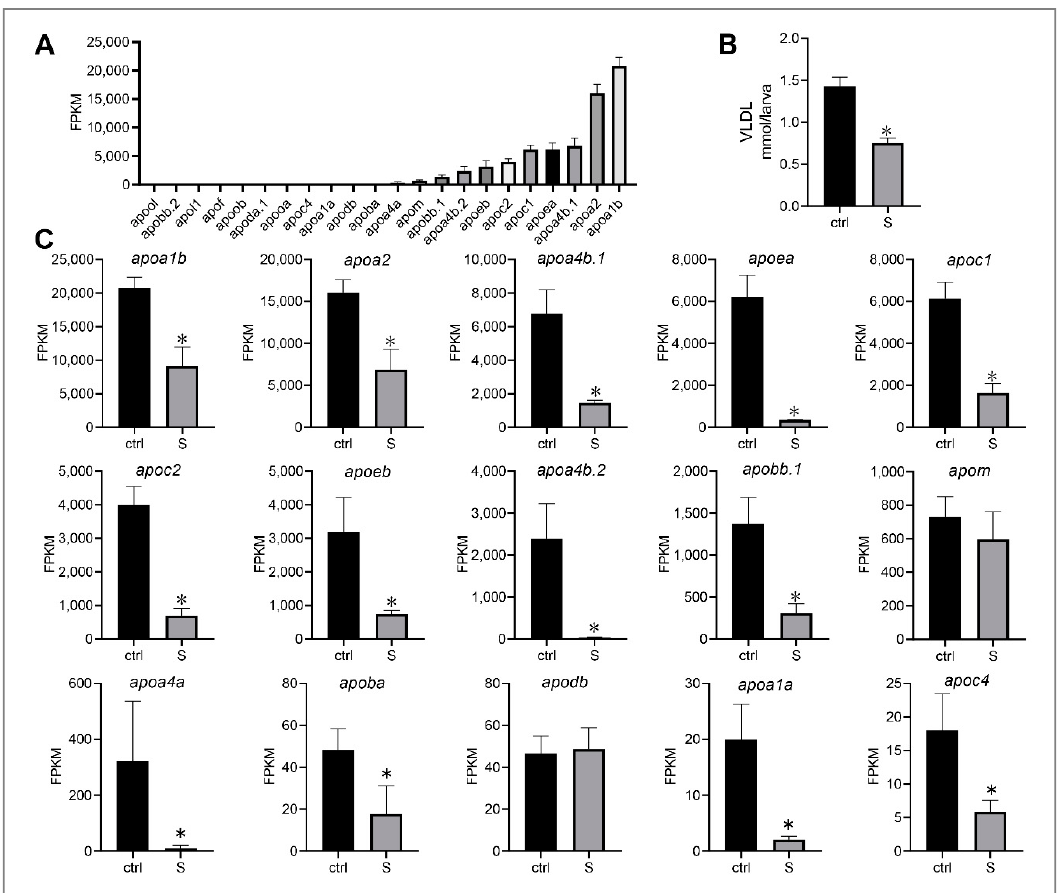
Figure 7. Effect of starvation on the gene expression involved in lipid transport in liver tissues. ( A ) Expression of apolipoprotein genes, including apoa1b , apoa2 , apoa4b.1 , apoea , apoc1 , apoc2 , apoeb , apoa4b.2 , apobb.1 , apom , apoa4a , apoba , apodb , apoa1a , apoc4 , apooa , apoda.1 , apoob , apof , apol1 , apobb.2 , and apool , were extracted in the control larvae from RNA-seq data. ( B ) Hepatic very low-density lipoprotein (VLDL) levels in the control and starved larvae at 8 dpf were determined. ( C ) Differential expression of the top 10 apolipoprotein genes in the control and starved larvae. The FPKM value represents the mean ± SEM of three independent RNA-seq biological replicates. * indicates significant differences ( p < 0.05).